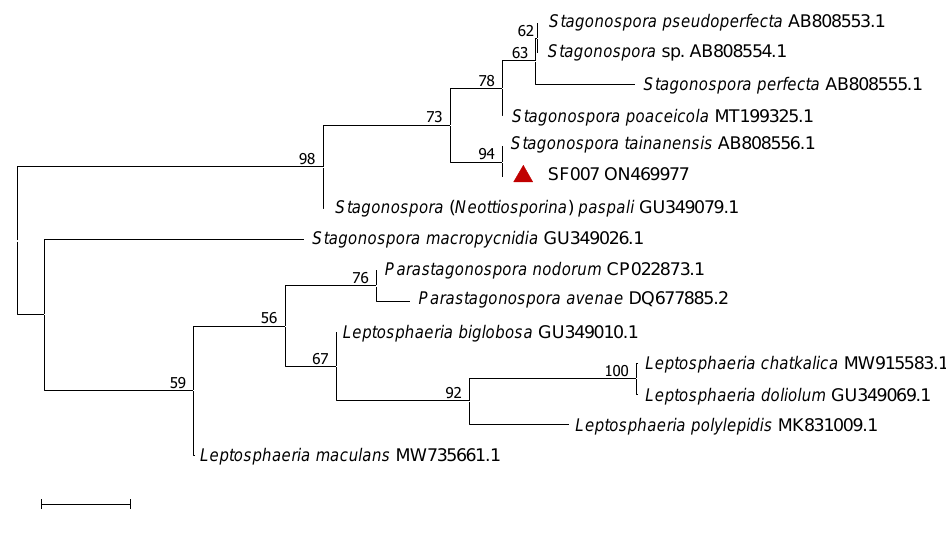
Figure 5. A maximum-likelihood phylogenetic tree based on the TEF-1 α amino acid sequences. The tree was developed using MEGA v.11.0.11.